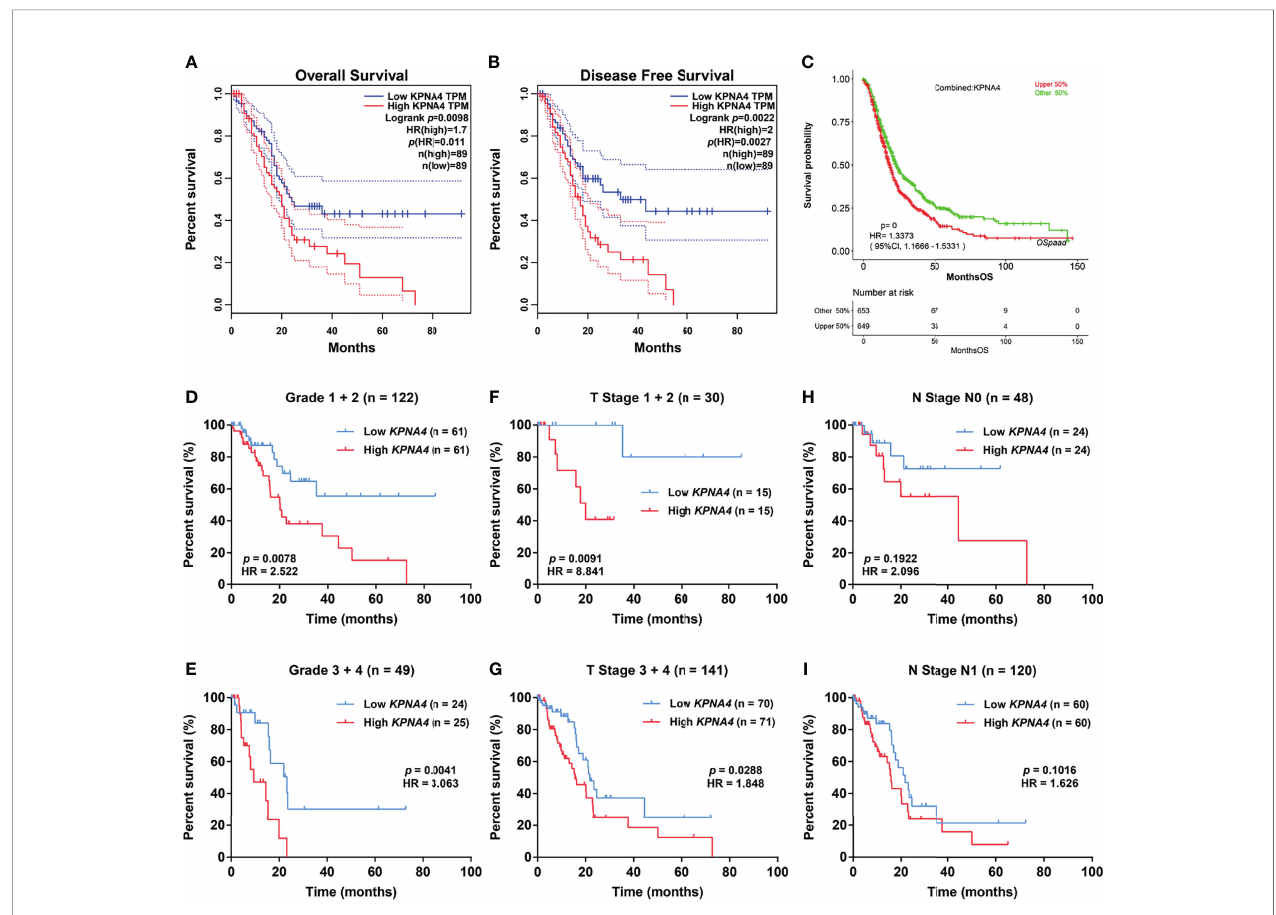
FIGURE 3 | Survival analysis of KPNA4 in PDAC. KPNA4 expression was signi fi cantly associated with the overall survival and disease-free survival of PDAC patients (A, B) , which was further con fi rmed by OSpaad (C) . Strati fi ed survival analysis revealed that high-expressed KPNA4 was correlated with poor prognosis independent of histological grade (D, E) or T stage (F, G) , while KPNA4 expression showed no signi fi cant association with survival when patients were strati fi ed by N stage (H, I) . Log-rank p- value < 0.05 was regarded to be statistically signi fi